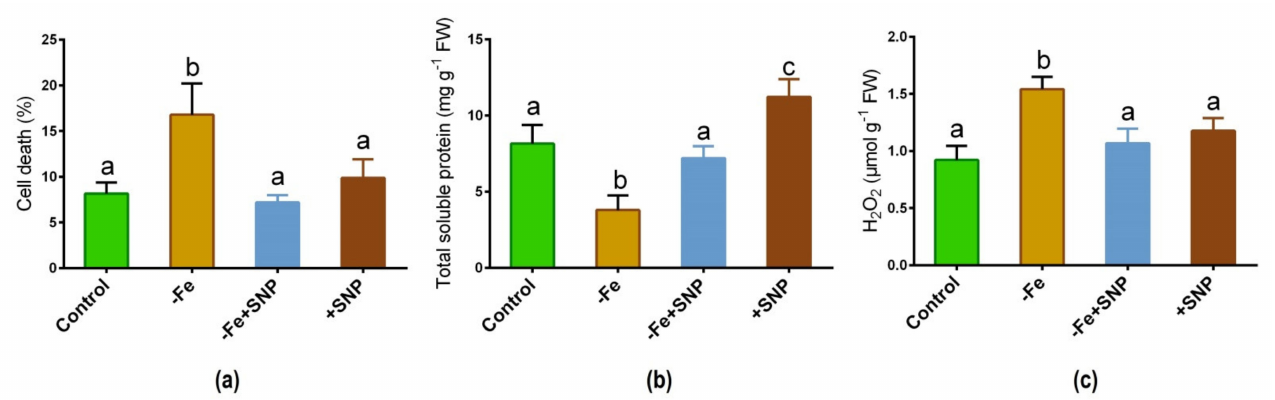
Figure 4. Cell death ( a ), total soluble protein ( b ), and hydrogen peroxide (H 2 O 2 ) ( c ) in alfalfa cultivated with different growth conditions: control (25 µ M FeNaEDTA); − Fe (0.1 µ M FeNaEDTA); − Fe (0.1 µ M FeNaEDTA) and sodium nitroprusside (SNP, 100 µ M) as nitric oxide (NO) donor; and SNP (100 µ M). Different letters above the error bar indicate significant differences ( p < 0.05) among means ± SD of treatments ( n =